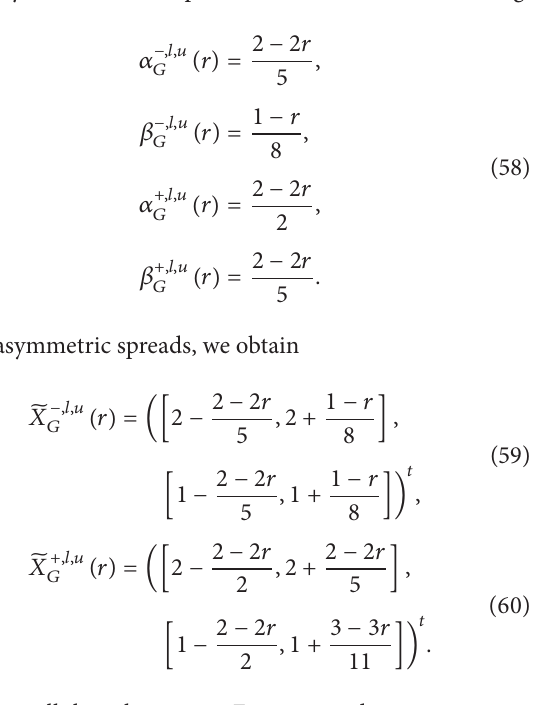
Figure 4: Compare the proposed solution ̃𝑥 −,𝑙,𝑢 2 (⊳), ̃𝑥 +,𝑙,𝑢 2 (◻) with (̃𝑥 ) (∙∙), (̃𝑥 −,𝑙 2 𝐷 (̃𝑥 ) (−) . 2 𝐴